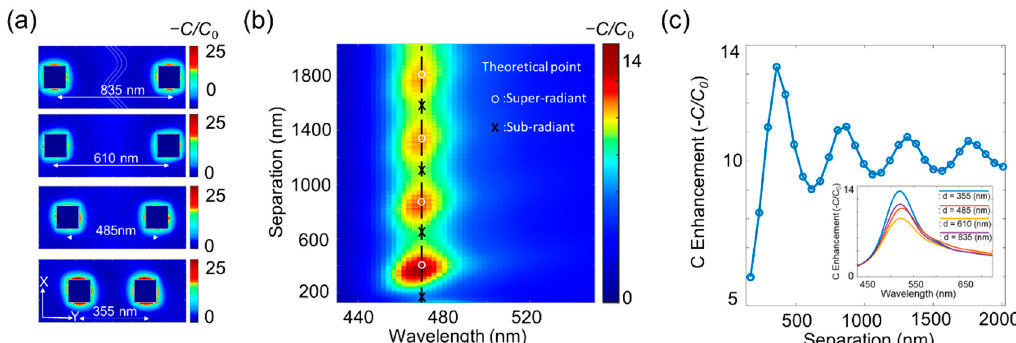
Figure 4. The average enhancement of optical chirality with changes in the separation of the Si nanoblock dimer. ( a ) Images of the enhanced optical chirality for four representative separations of the dimer at the wavelength of 470 nm. ( b ) Image of the spectrums of the optical C enhancement as the separation is tuned from 135 nm to 2025 nm. White circle marks in the map indicate the theoretical maximum point of the radiation field, and black cross marks in the map indicate the theoretical minimum point of the radiation field. ( c ) The C enhancement at the resonance wavelength of 470 nm. The inset in ( c ) shows the spectrums for four representative separations in ( a ).